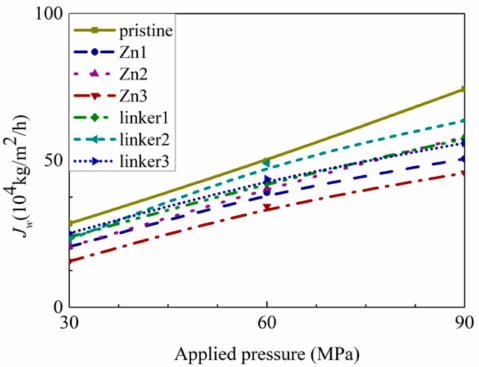
Figure 9. Dependence of water flux J W on the applied pressure for the respective ZIF-8 membranes.